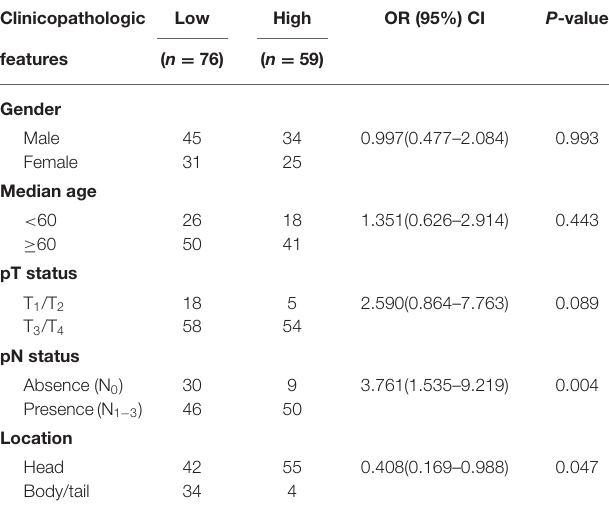
TABLE 1 | Pooled analysis of the correlation between UBR5 expression and clinicopathologic features in pancreatic cancer cases from TMA and TCGA